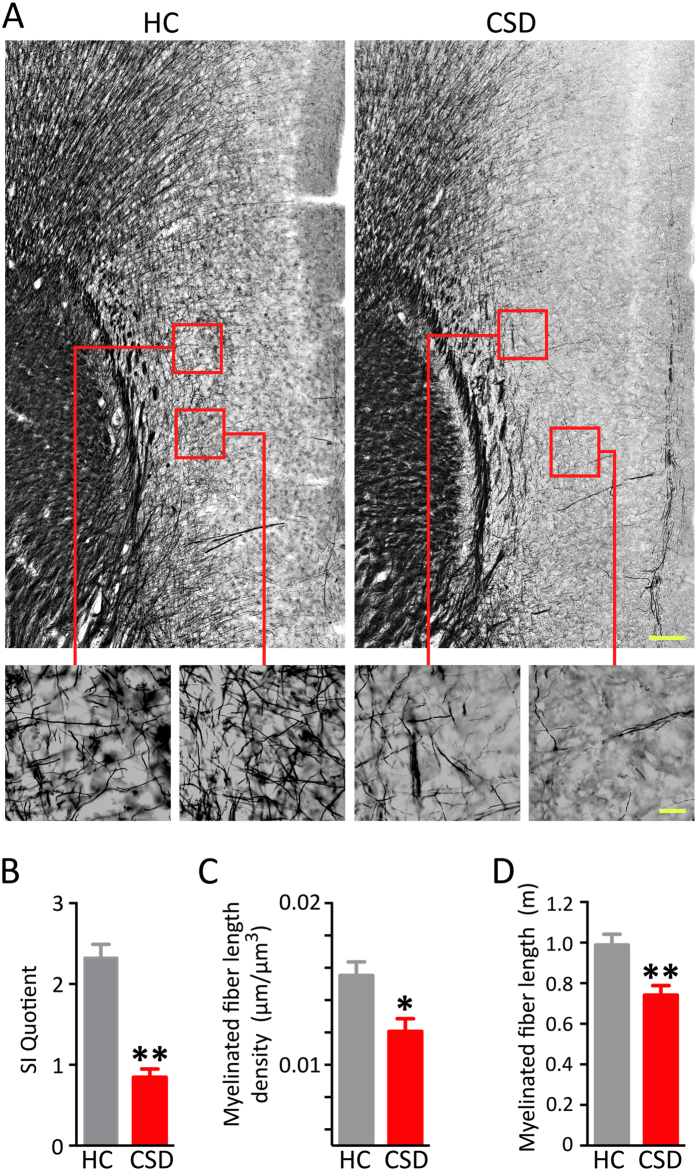
CSD decreased myelinated fiber density in the mPFC and increased social avoidance.(A) Representative photomicrographs of Black Gold-stained myelinated fibers show comparative differences between HC and CSD cortices. Scale bars = 100 μm and 20 μm for low- and high-magnification photographs, respectively. (B) CSD significantly reduced social interaction (SI). (C) CSD significantly reduced myelinated fiber density (C) and total myelinated fiber length (D) in the mPFC. Results are expressed as mean ± SEM (n = 6 per group). Unpaired two-tail t-test: *p < 0.05, **p < 0.005.